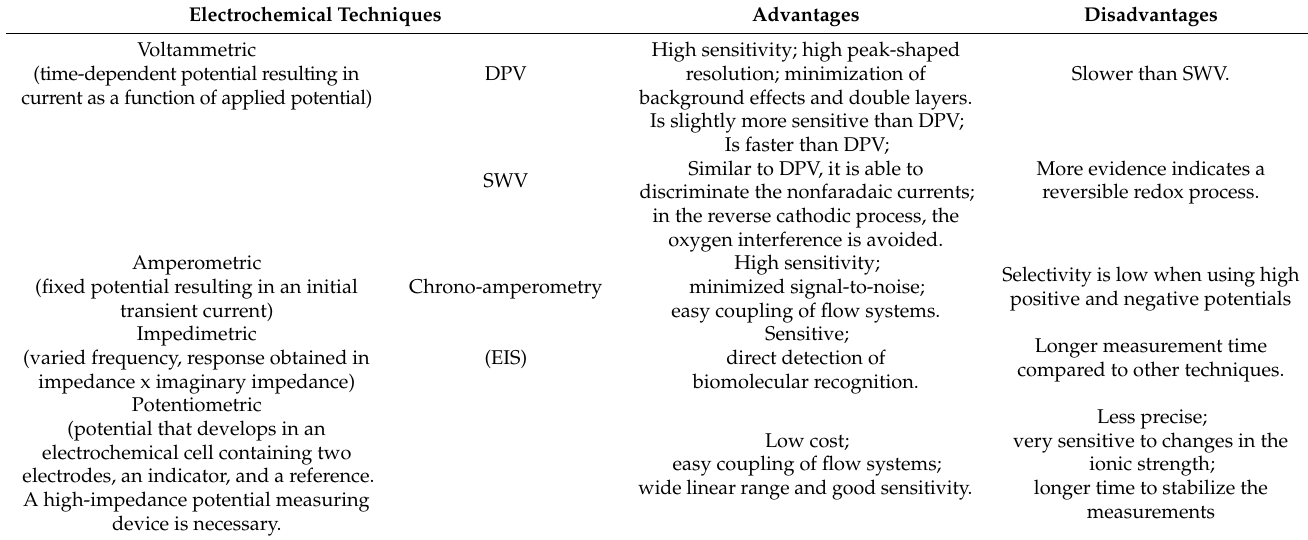
Table 1. Characteristics of electrochemical techniques commonly used in antigen